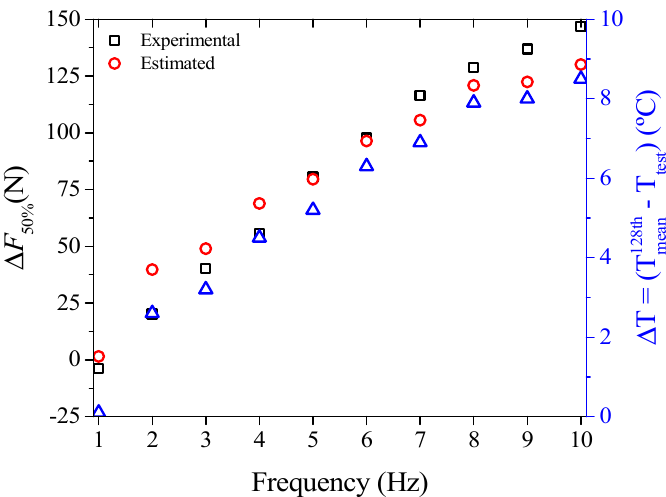
Figure 17. Estimated vs. experimental force increase Δ F 50% as a function of loading frequency.